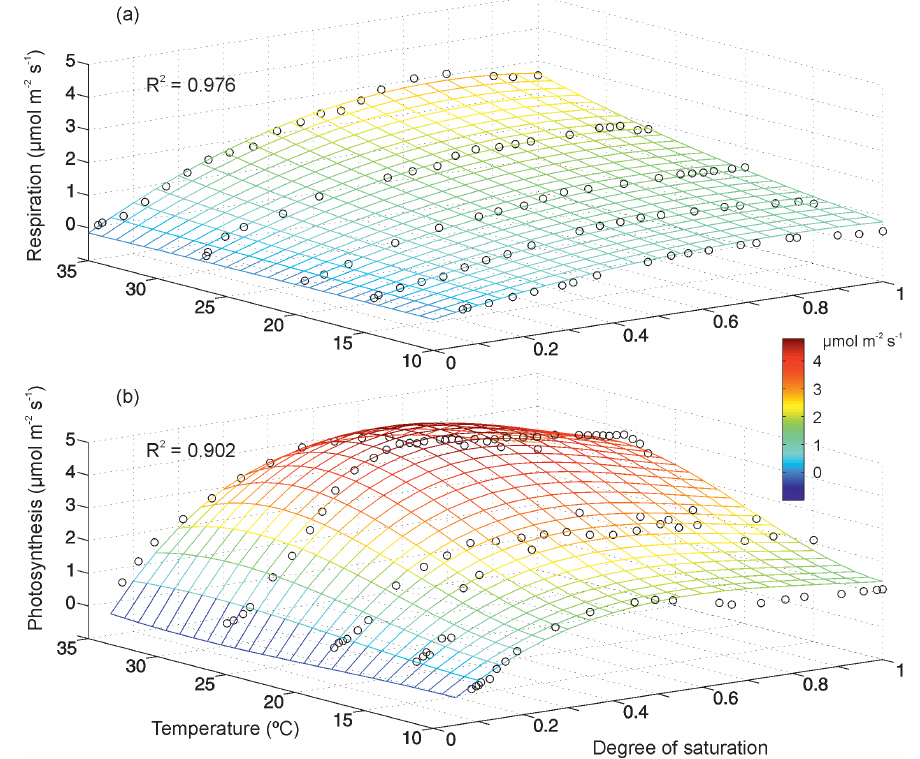
Figure 3. Measured and fitted bulk respiration (a) and photosynthesis (b) of the lichen top crust as functions of temperature and water